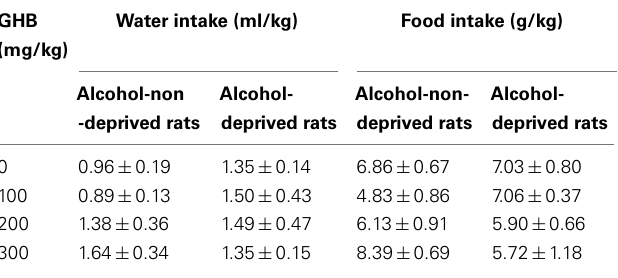
Table 1 | Lack of effect of the acute administration of γ -hydroxybutyric acid (GHB) on water and food intake in Sardinian alcohol-preferring (sP) rats exposed to the “alcohol deprivation effect”